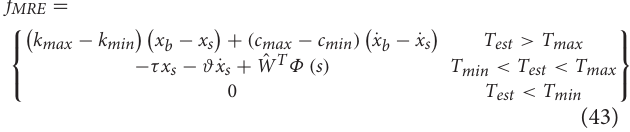
Frontiers in Materials |